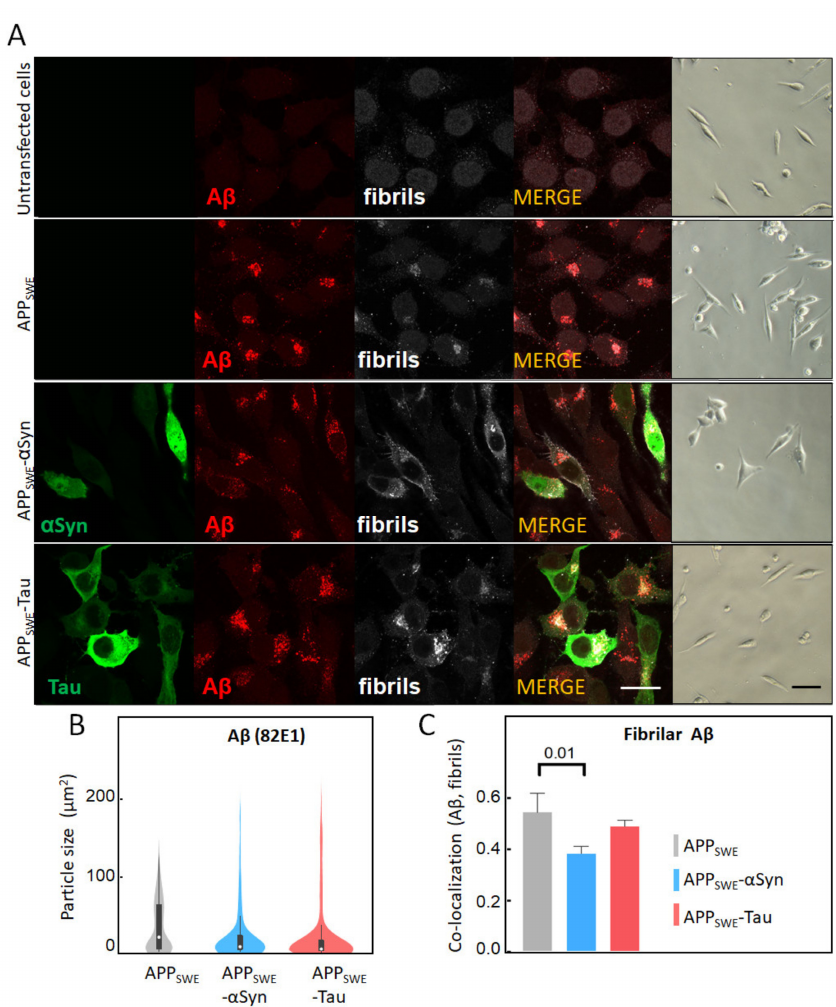
Figure 1. Immunofluorescent characterization of A β in cellular models of Alzheimer’s disease (AD). ( A ) Immunofluorescent labeling of A β with 82E1 (red) and amyloid fibrils with OC78 (white). The green fluorescence channel corresponds to mutated Tau (P301L) or α Syn (A53T) coupled to GFP. Bright-field images show the condition of fluorescence-activated cell sorting (FACS)-sorted cells (Supplementary Figures S2–S5). The scale bar is 20 µ m. ( B ) Quantification of particle size was calculated using surface areas in immunosignal corresponding to 82E1 immunoreactivity. Aggregated A β was computed by co-localization analysis of A β (82E1) and amyloid fibrils (OC78). A threshold was set at 5% of max size (Supplementary Figure S6). ( C ) Statistical analysis of the co-localization of A β with fibrillary A β : one-way ANOVA ( p < 0.01) ± s.d; n = 25–35 cells per sample. A coefficient of 1 is equal to 100%